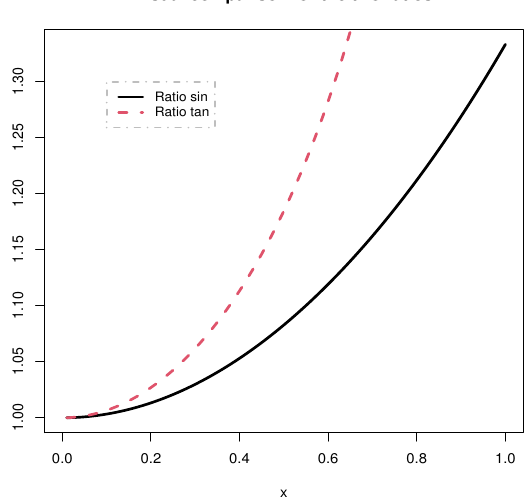
Figure 3. Visual comparison between sin − 1 x